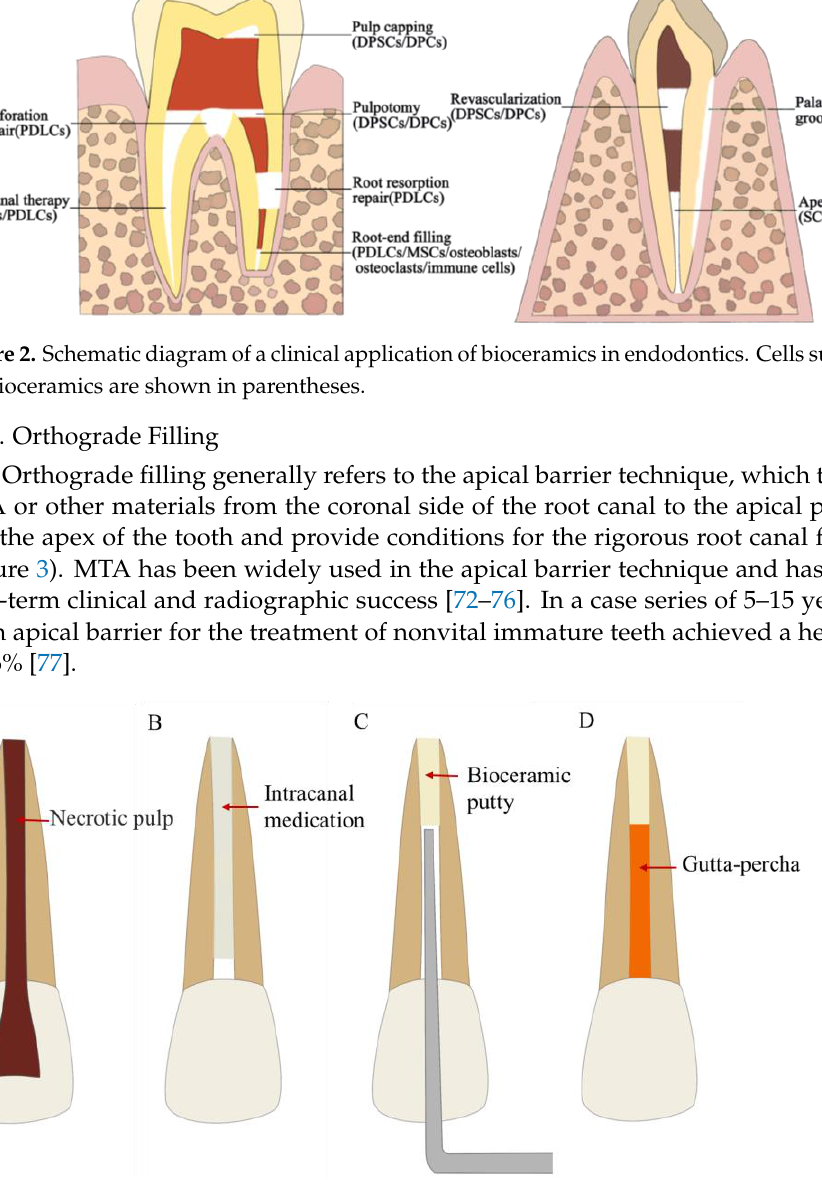
Figure 2. Schematic diagram of a clinical application of bioceramics in endodontics. Cells surrounding the bioceramics are shown in parentheses.